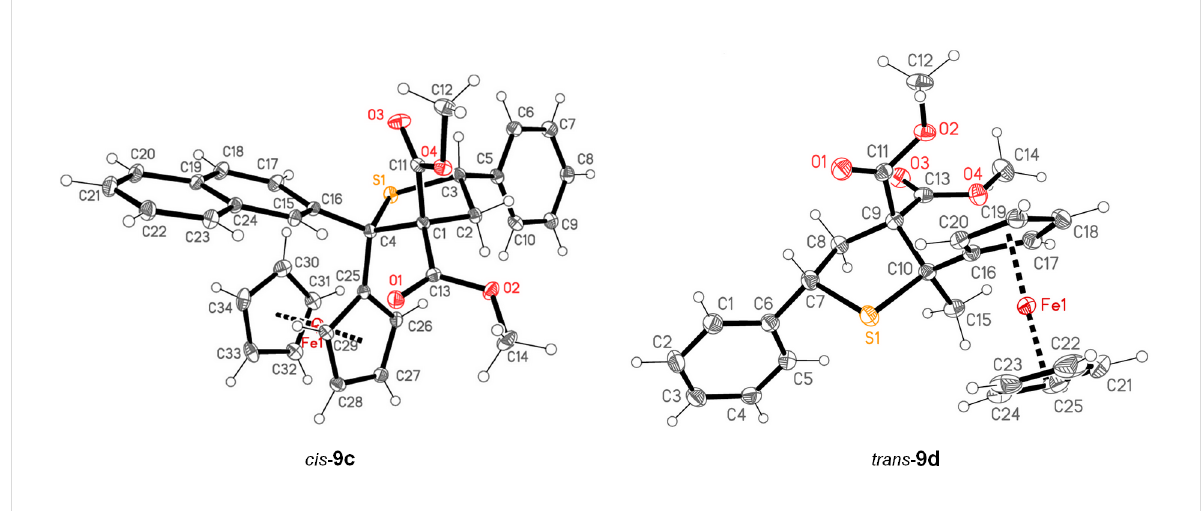
Figure 1: Thermal ellipsoid plots of the molecular structures of cis - 9c and trans - 9d drawn using 50% probability displacement ellipsoids. The termi- nology cis and trans referred to the relative orientation of Ph and Fc groups.